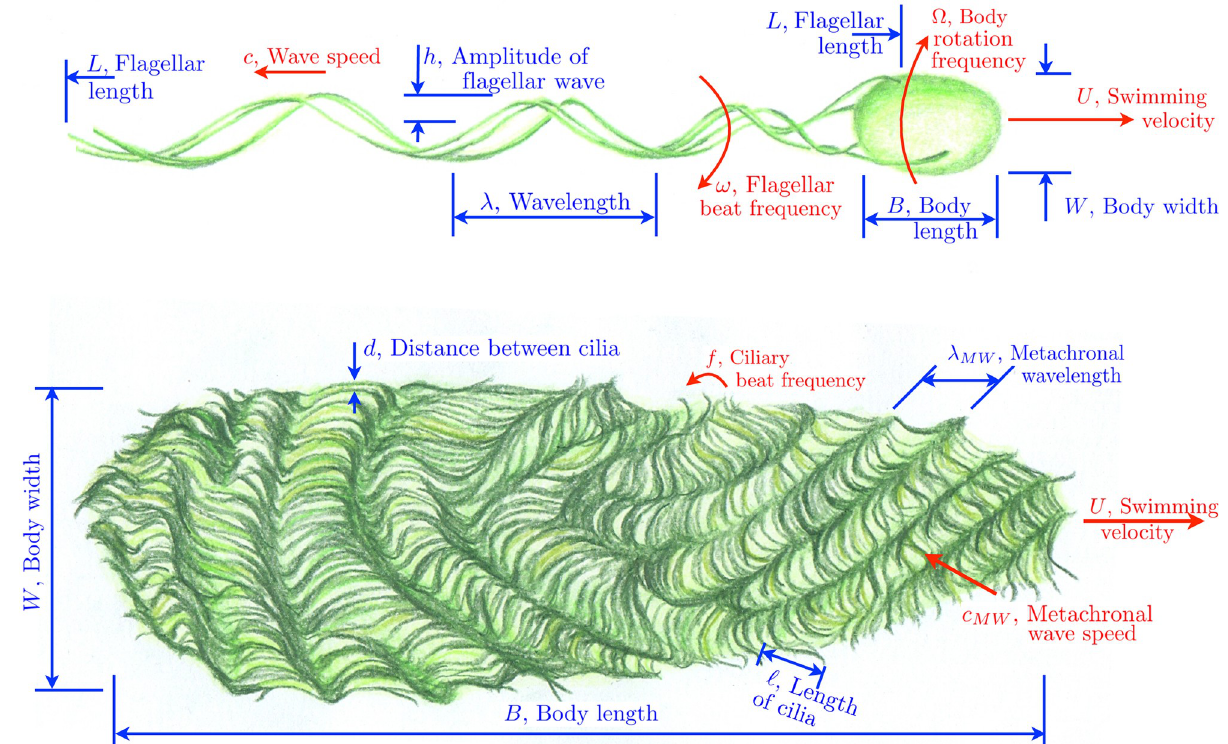
Fig 1. Top: Geometrical and kinematic parameters of flagellated swimmers, illustrated here for a bacterium; we use the same symbols for cells employing planar or helical waves for simplicity. Bottom: Geometrical and kinematic parameters of ciliated swimmers. Drawings by Marcos F. Velho